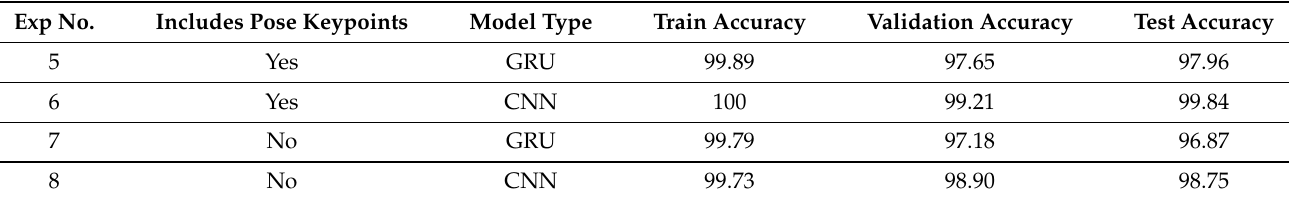
Table 6. Experiments’ results on the LSA64 dataset.